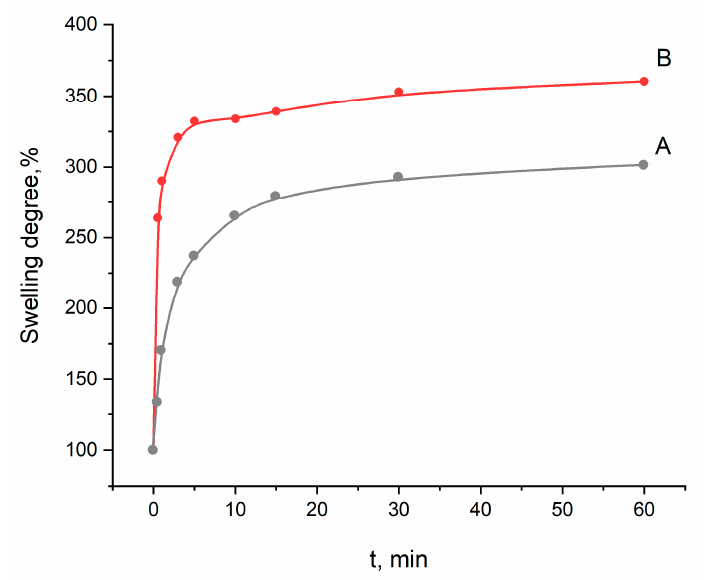
Figure 9. Swelling curve of sample 8 (PVP-SA-HA)—A; sample 6 (PVP-SA)—B.